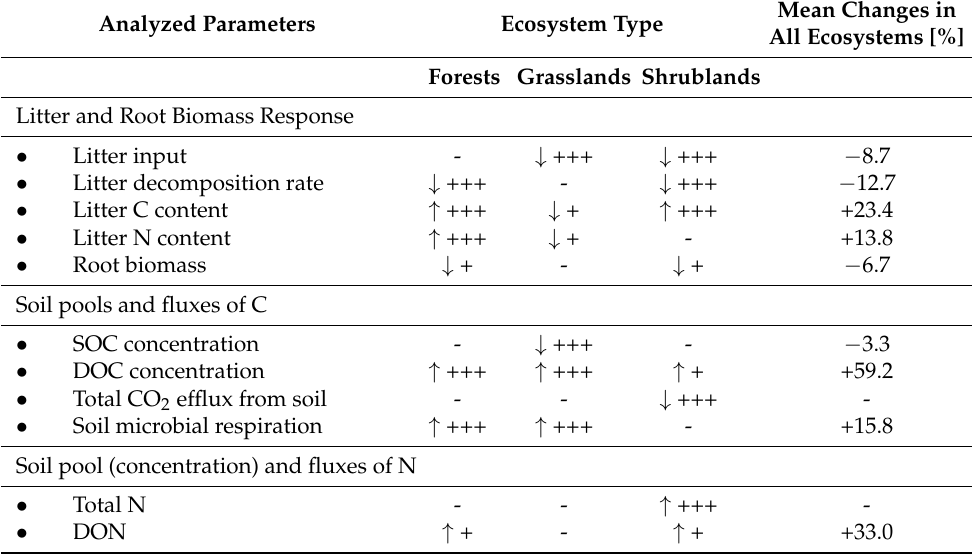
Table 1. Effects of drought on soil C and N dynamics in three different ecosystems according to the study of Deng et al.